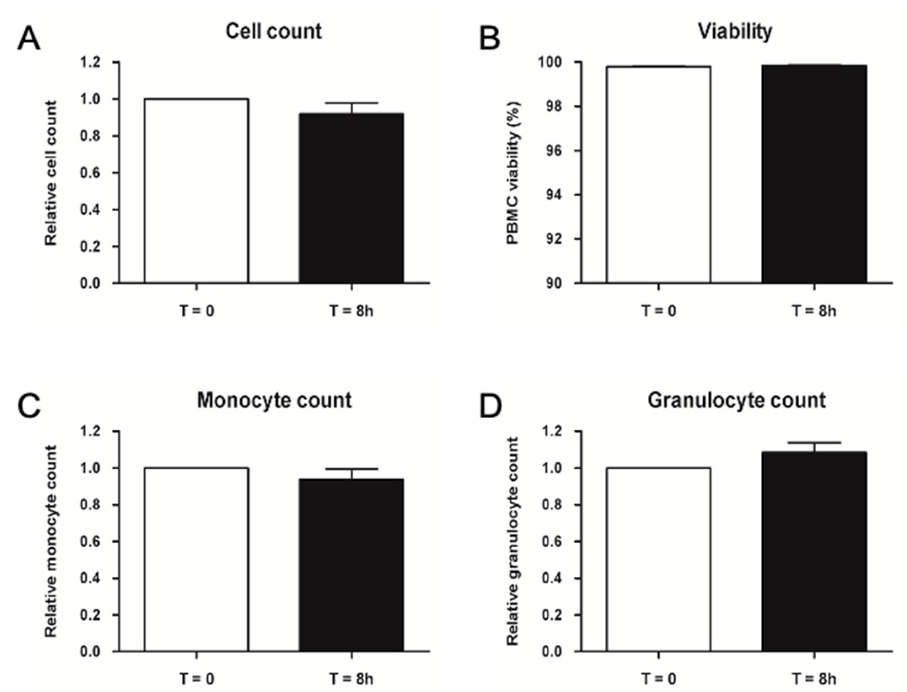
Figure 5. Validation of the 8 h storage at room temperature of peripheral blood before processing. Average cell count ( A ), viability ( B ), monocyte ( C ) and granulocyte ( D ) count of PBMC isolated at T = 0 and T = 8 h. Relative values are normalized to control samples isolated at T = 0. Data are represented as mean ± SEM, N = 3.